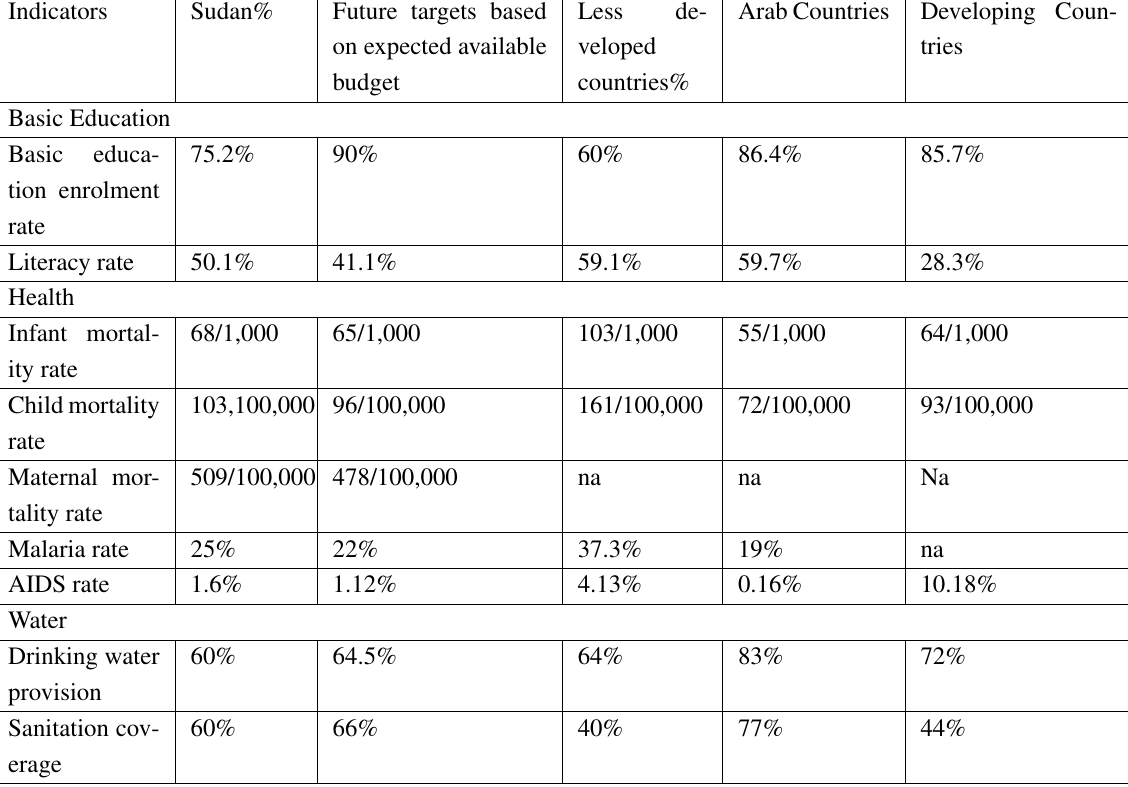
Table 1. Basic poverty indicators for Sudan compared to othercountries (LDCs) and Arab countries,Zakieldeen (2009) Indicators Sudan% Future targets based